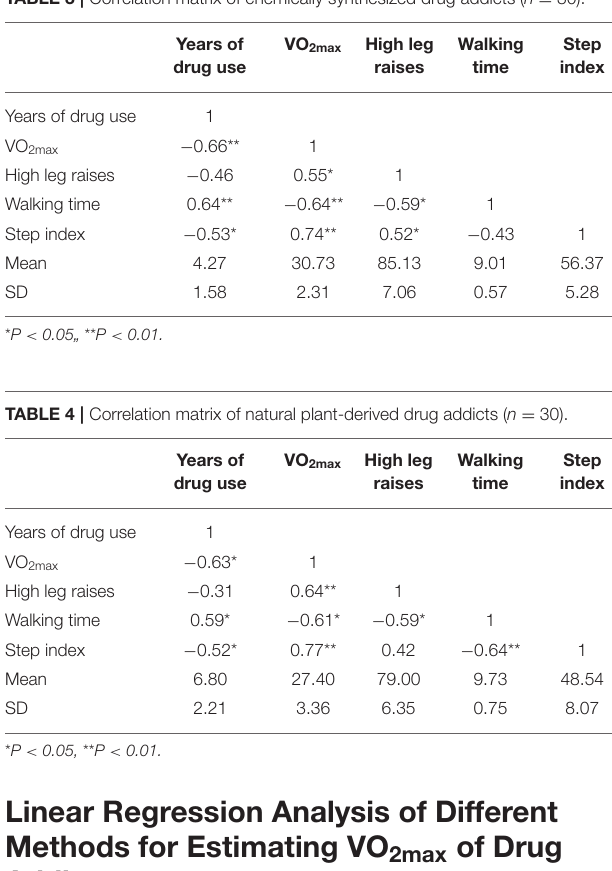
TABLE 3 | Correlation matrix of chemically synthesized drug addicts ( n = 30).